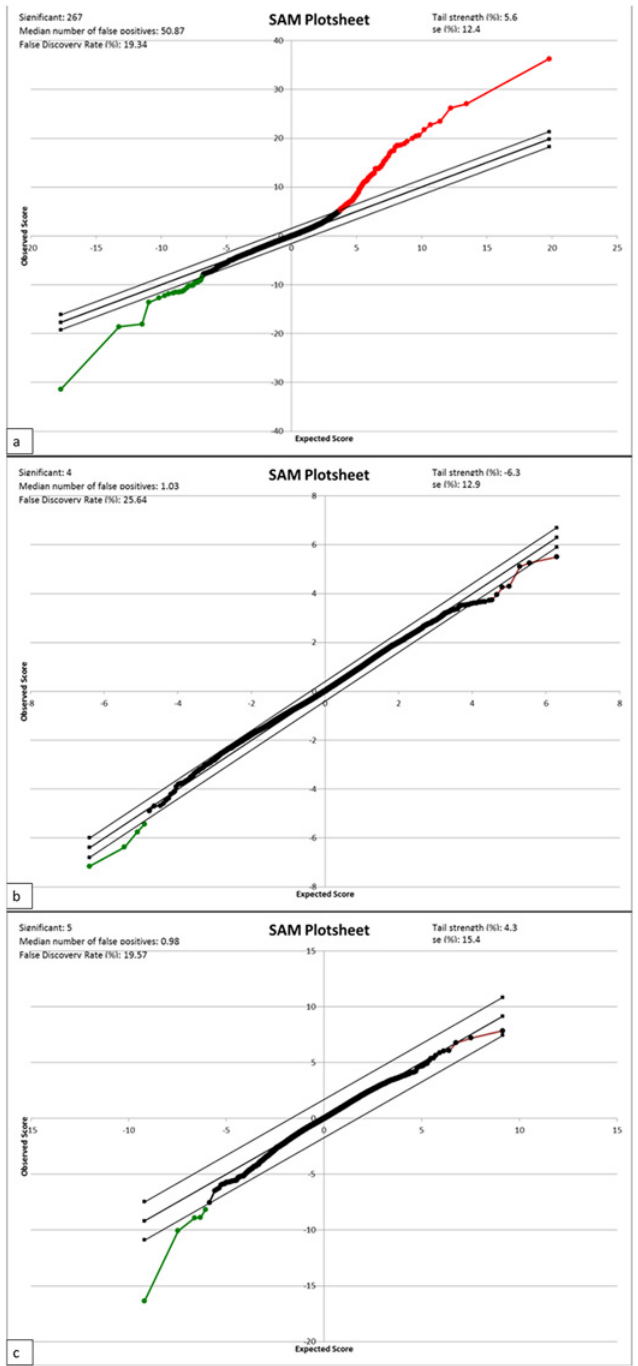
Fig 3. SAM plots: a — odontoblasts vs pre-secretory ameloblasts, b — odontoblast vs secretory ameloblasts, c — pre-secretory vs secretory ameloblasts. The red portion shows genes that are expressed at a higher level while the green portion shows genes that are expressed at a lower level with a FDR of 20%.